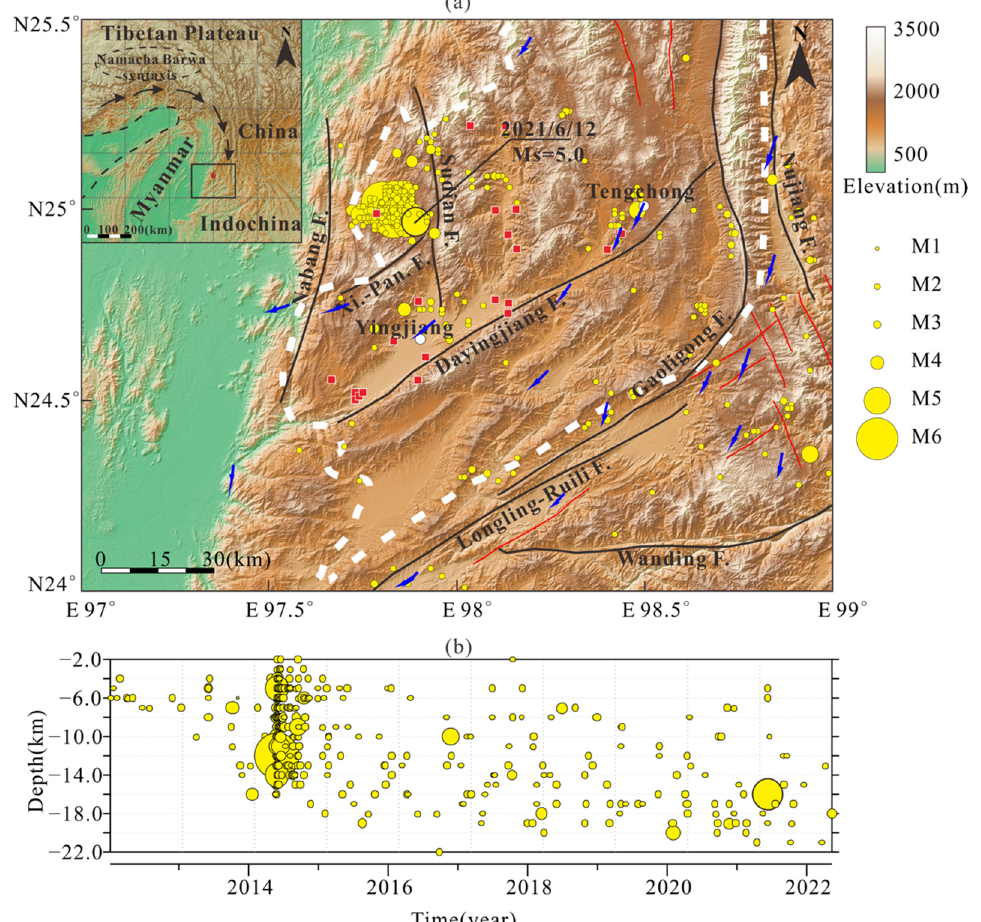
Figure 1. ( a ) Seismotectonic map of the Yingjiang area describing the tectonic setting and seismic activity distribution. Black lines are the main faults, and red lines are secondary faults (e.g., [11–14]). Yellow circles indicate the distribution of historical earthquakes in Yingjiang (data obtained from NEDC, https://data.earthquake.cn, accessed on 15 December 2022). Blue arrows represent the GPS velocity vectors [15]. Red squares indicate the distribution of 24 hot springs in the study area [16,17]. The thick white dashed line illustrates the tectonic boundary of the Tengchong block [18]. Inset is the location map. Black arrows in the inset show GPS velocity vectors of crustal motion relative to Eurasia [19]. ( b ) Distribution of focal depths of historical earthquakes in Yingjiang.